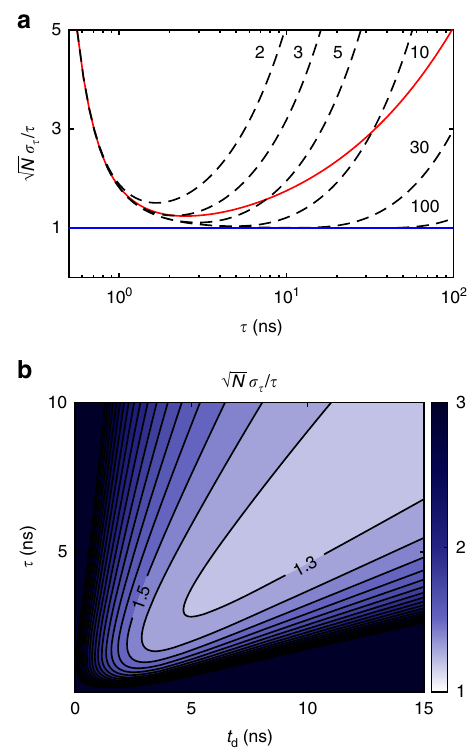
Fig. 6 Lifetime estimation error. a Cramér-Rao bound on lifetime estimation accuracy for a monoexponential fl uorescence decay using different numbers of bins. Dashed lines compare two to n -bin lifetime measurements in the case where the measurement window is n × 4 ns. The red line corresponds to two-bin lifetime estimation at 4 ns t d without fi nite measurement window (i.e., ideal step function gate). Note that the range of maximum sensitivity can be shifted with t d . The blue line indicates the shot ffiffiffiffi p N noise limit: σ τ = τ ¼ 1 = . b Simulated lifetime resolution for a realistic two- bin PC experiment with a 1 ns 10 – 90% logistic rise time PC gate and 1 ns σ e